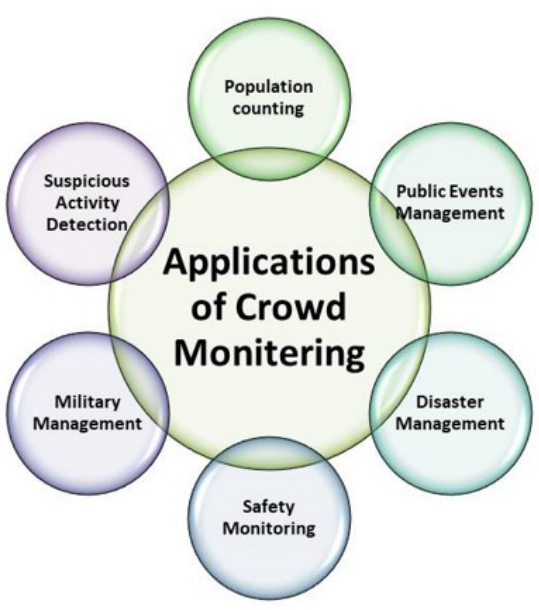
Figure 1. Applications of crowd monitoring and management